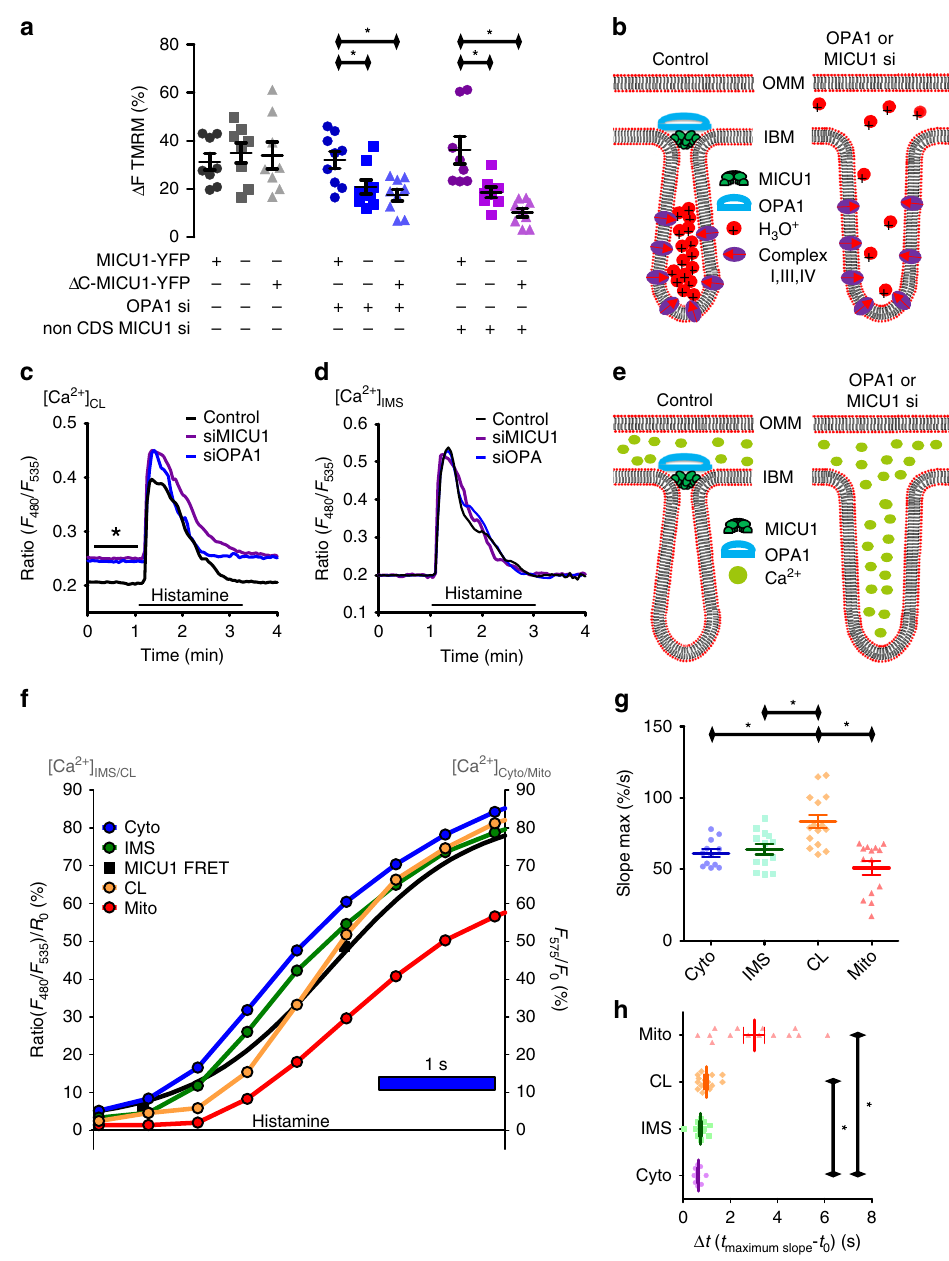
Fig. 5 Knockdown of OPA1 and MICU1 decreases ψ mito and increase cristae Ca 2 + . a HeLa cells expressing MICU1-YFP or Δ C-MICU1-YFP were transfected with Control (gray), OPA1 (blue), or MICU1 (magenta) siRNA. The TMRM Δ fl uorescence intensity after addition of 2 µ M FCCP was measured ( n MICU1-YFP; = 8; n = 8; n = 8; n = 9; n = 9; n = 9; n = 8; Δ C-MICU1-YFP; Control si Δ C-MICU1-YFP; OPA1 si no-FP; Control si MICU1-YFP; OPA1 si no-FP; OPA1 si MICU1-YFP; nonCDS MICU1 si Control si n = 8; n Δ = 9). b Schematic representation of the impact of MICU1 or OPA1 depletion on ψ no-FP; nonCDS MICU1 si C-MICU1-YFP; nonCDS MICU1 si mito caused by enlarged cristae junction. c HeLa cells were transfected with the cristae Ca 2 + sensor CL-GEMGeCO1 and Control (black), OPA1 (blue), or MICU1